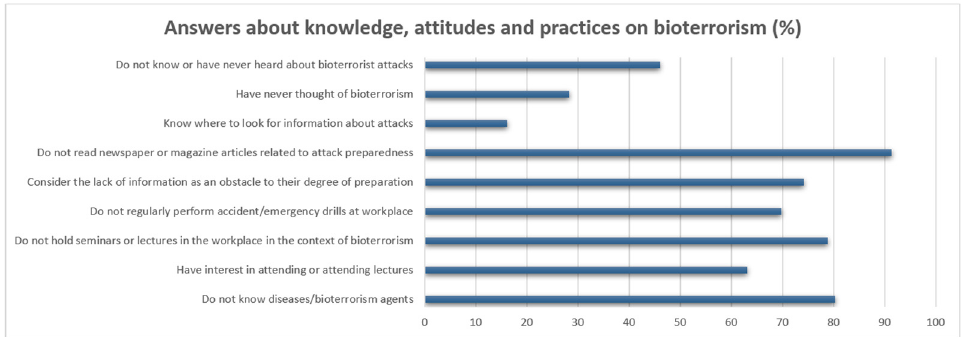
Figure 2. Answers about knowledge, attitudes and practices about bioterrorism.